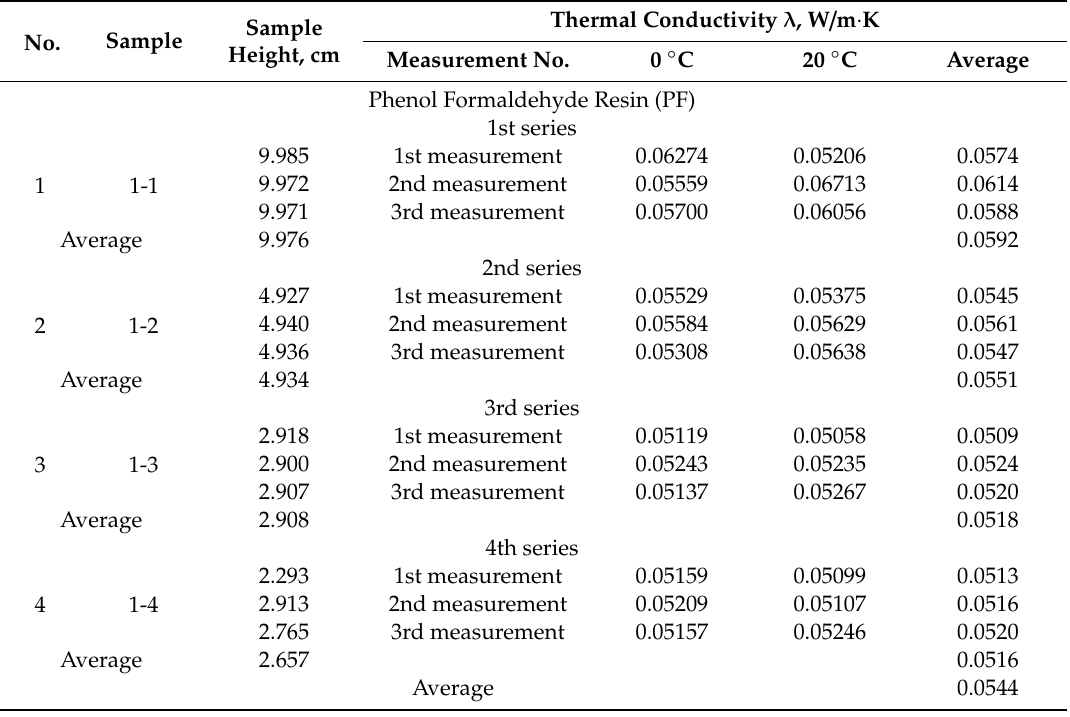
Table 5. Thermal conductivity coe ffi cient of the samples with the phenol formaldehyde (PF) resin glue. No.